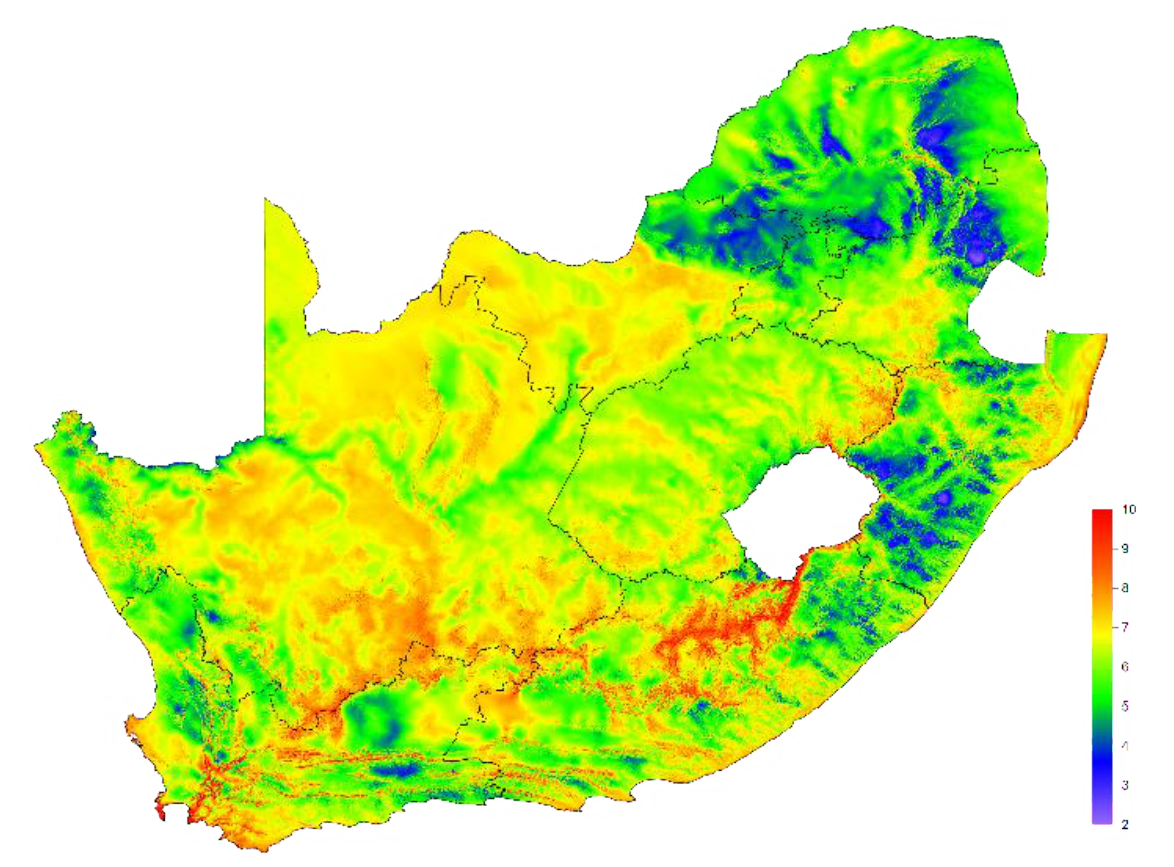
Figure 8. The South African wind r esource map at 100 m Table 1. Comparison between the annual radiation potential of South Africa and other selected countries.